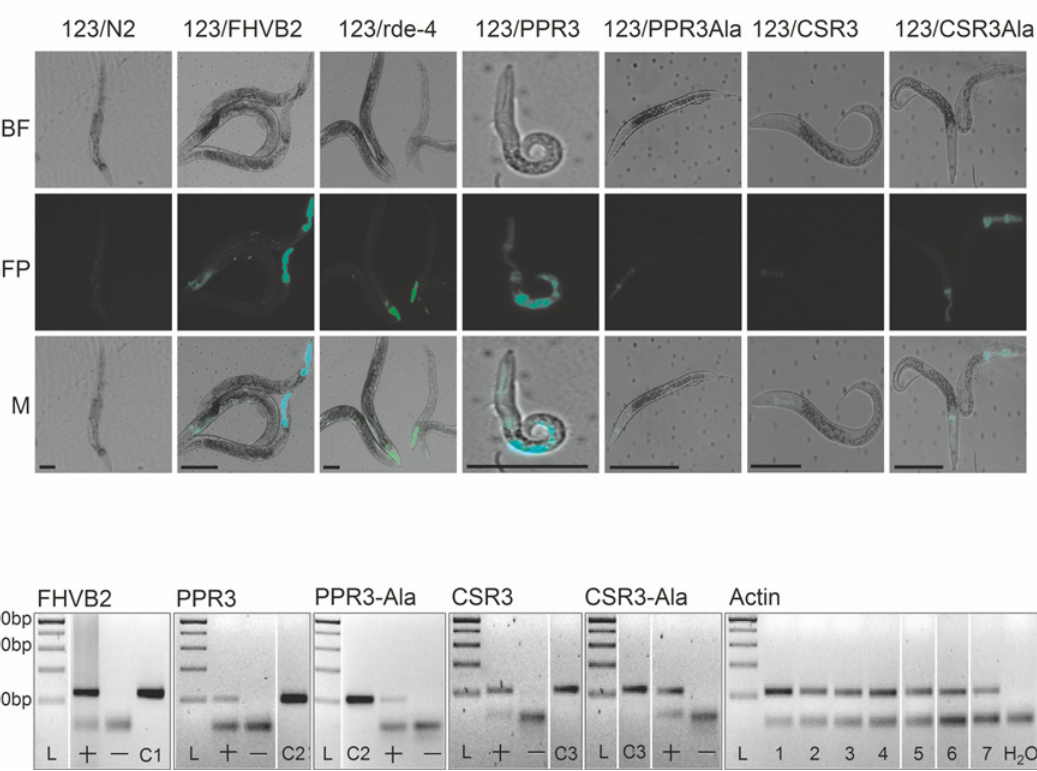
Fig 7. Suppression of antiviral RNAi by PPR3 in C . elegans . ( A ) GFP fluorescence and stunted growth of the heat shock — treated C . elegans strain 123/ PPR3 expressing PPR3 and a mutated flock house virus (FHV) genome (FR1gfp), in which the B2 gene for an RNAi suppressor had been replaced with GFP , and in C . elegans strain 123/FHVB2 expressing FHV B2 in the FR1gfp background under control of a heat shock — inducible promoter. Strain 123/rde-4 is defective in RdRp function, hence deficient in RNAi and allows GFP expression in pharyngeal cells. In contrast, the lines expressing PPR3-Ala, CSR3, or CSR3-Ala show only faint signals of the pharyngeal-specifically expressed cyan fluorescent protein used as a co-injection marker. Images taken under a microscope in bright field (BF) or with a GFP fluorescence filter (GFP) were merged (M). Scale bars, 100 μ m. ( B ) Transgene expression was detected by RT- PCR on DNase-treated total RNA extracted from worms. PCR template (100 ng) was cDNA (indicated by a +) or extracted RNA that was DNase-treated but not reverse transcribed ( — ). Positive controls (DNA): C1, FHV RNA1 plasmid (includes B2 ); C2, PPR3 plasmid; C3, CSR3 plasmid. Detection of actin mRNA was used as an additional control. PCR products were verified by sequencing. L, Gene Ruler DNA ladder